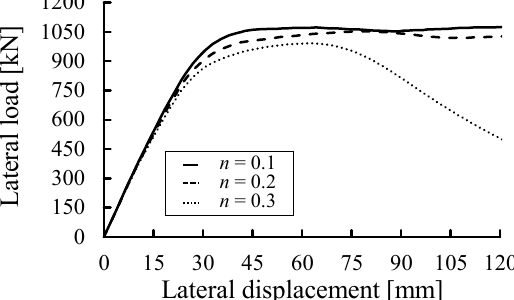
Figure 8. Lateral load versus lateral displacement (C-009-030, L c / L = 0.4).